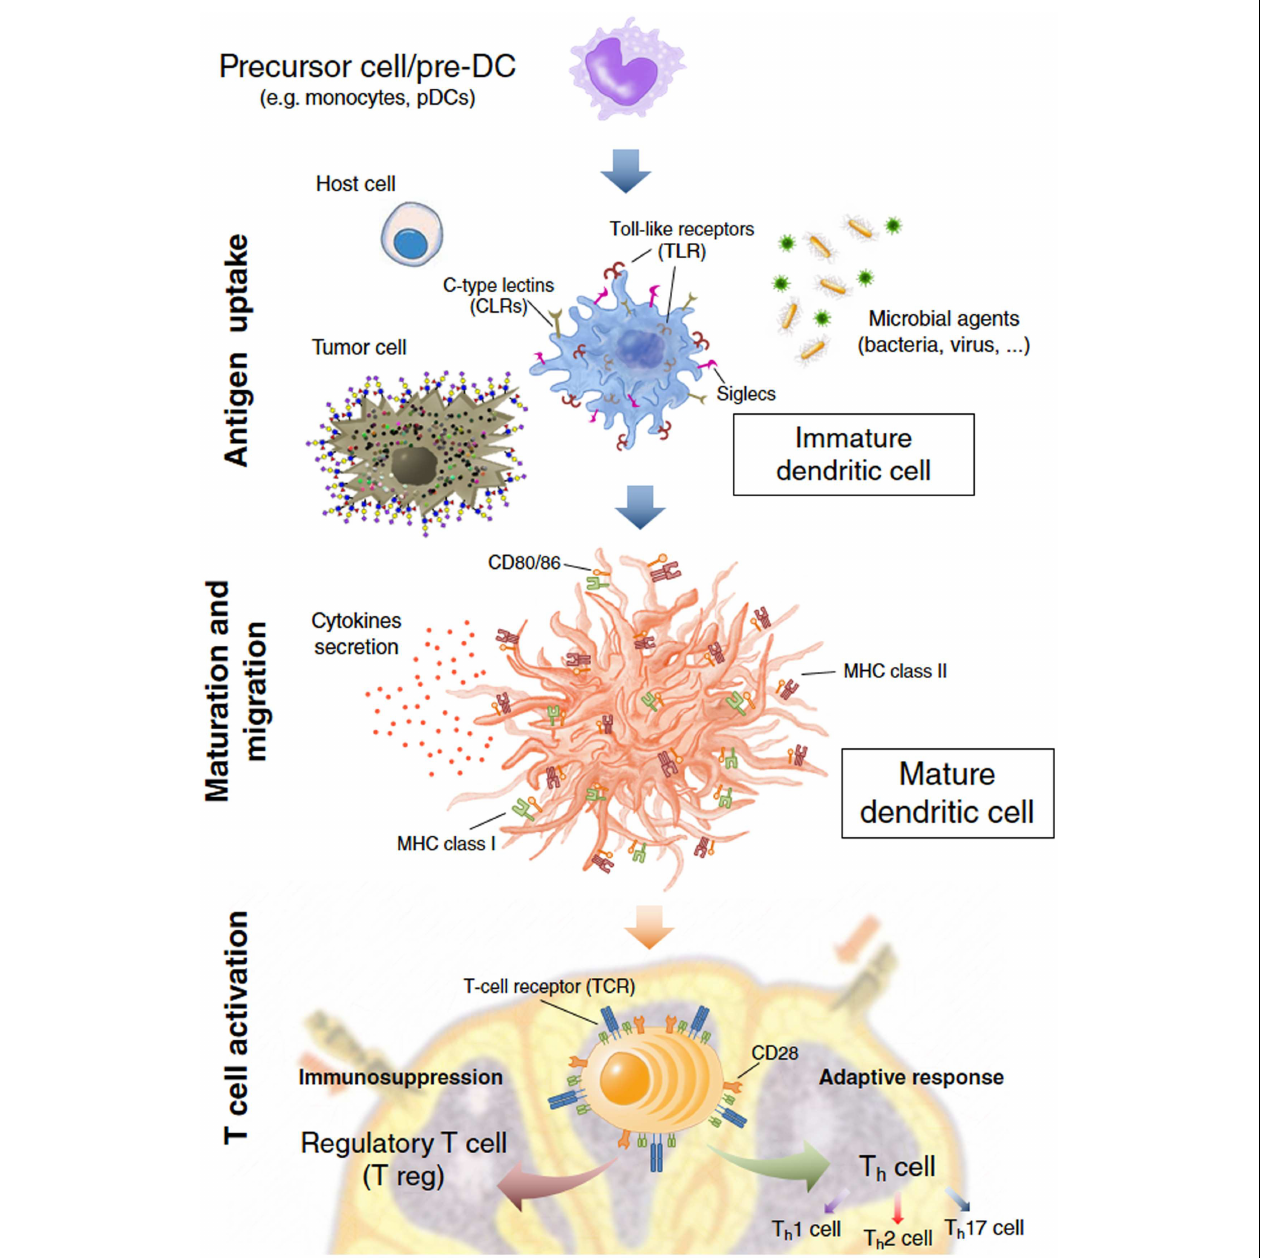
and other cell surface receptors like Siglecs or C-type Lectins (CLRs); maturation and migration toward the secondary lymphoid organs; T cell activation where DCs present the processed antigens toT cells eliciting a specific and enduring response or tolerance fromT